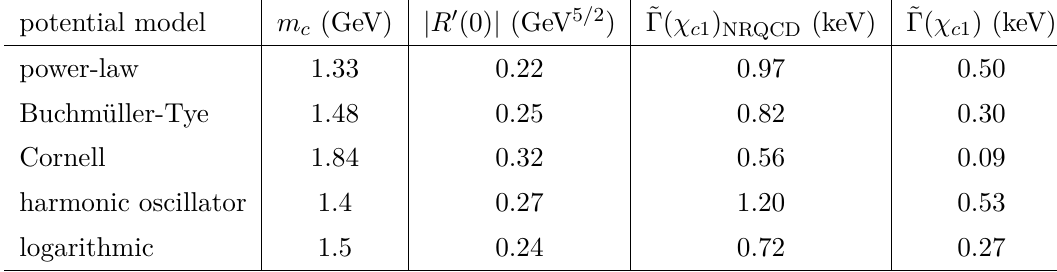
Table 1 . Reduced width, see eq.